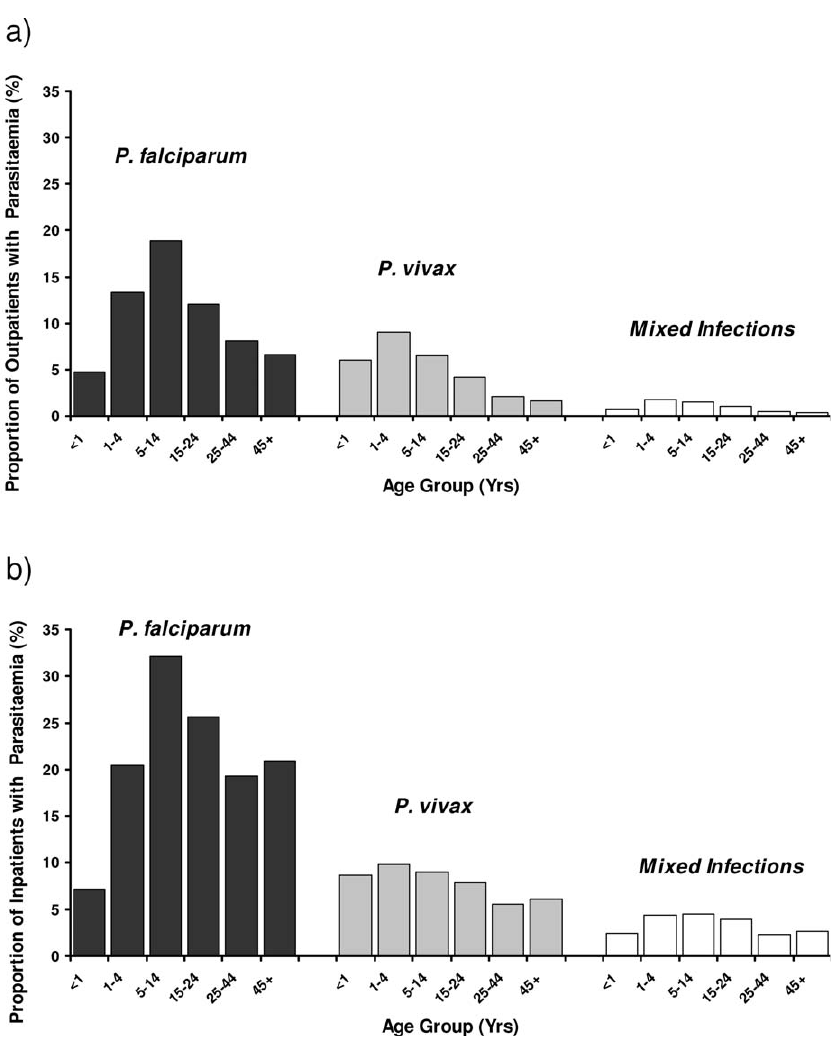
Figure 1. Age Stratified Proportions of Hospital Patients with Malaria Bars represent proportion of all patients attending outpatients (A) or admitted to hospital (B) who were parasitaemic. doi:10.1371/journal.pmed.0050128.g001 PLoS Medicine |